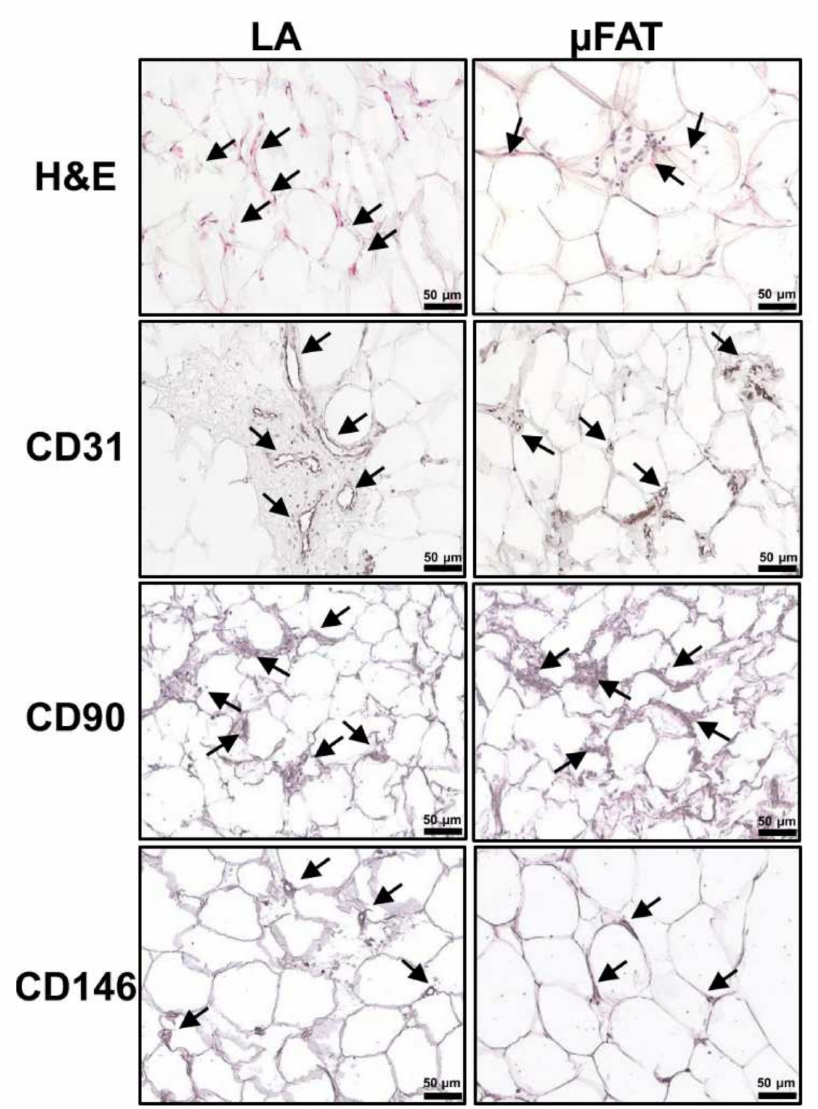
Figure 1. Immunohistochemical localization of vascular, stromal and perycitic markers in lipoaspirate (LA) and microfragmented ( µ FAT) tissues. Human adipose tissues were examined by immunohisto- chemistry for the expression of α -CD31 (vascular endothelium), α -CD90 (stromal cells) and α -CD146 (perycites). Positively stained structures are marked with arrows. Control specimen stained with H&E (without antibody) is shown on top. Representative images for each tissue type are